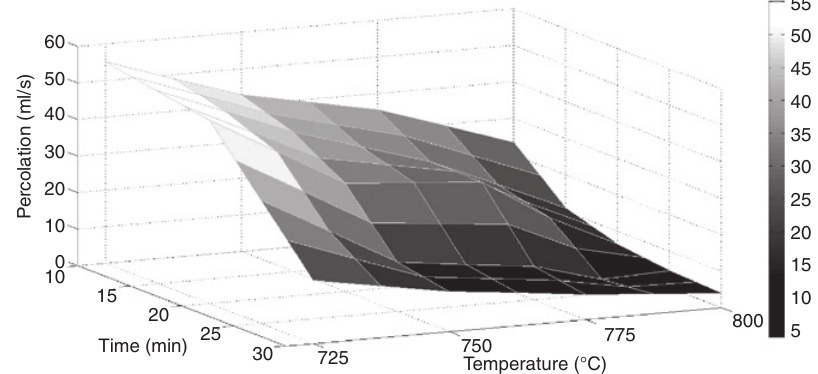
Figure 9: MG30 filter percolation as a function of sintering time and temperature.